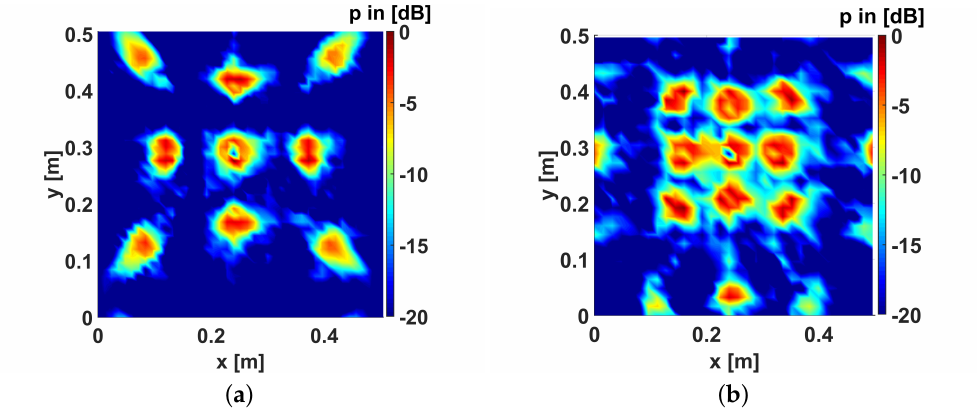
Figure 14. Amplitude at the top of the wooden particleboard with a ø20 mm piece of paper. Evaluated with the re-radiation method for the frequency 48–52 kHz, with ( a ) d x = d y = 12 mm and ( b ) d x = d y = 16 mm a grid of the size 512 mm × 512